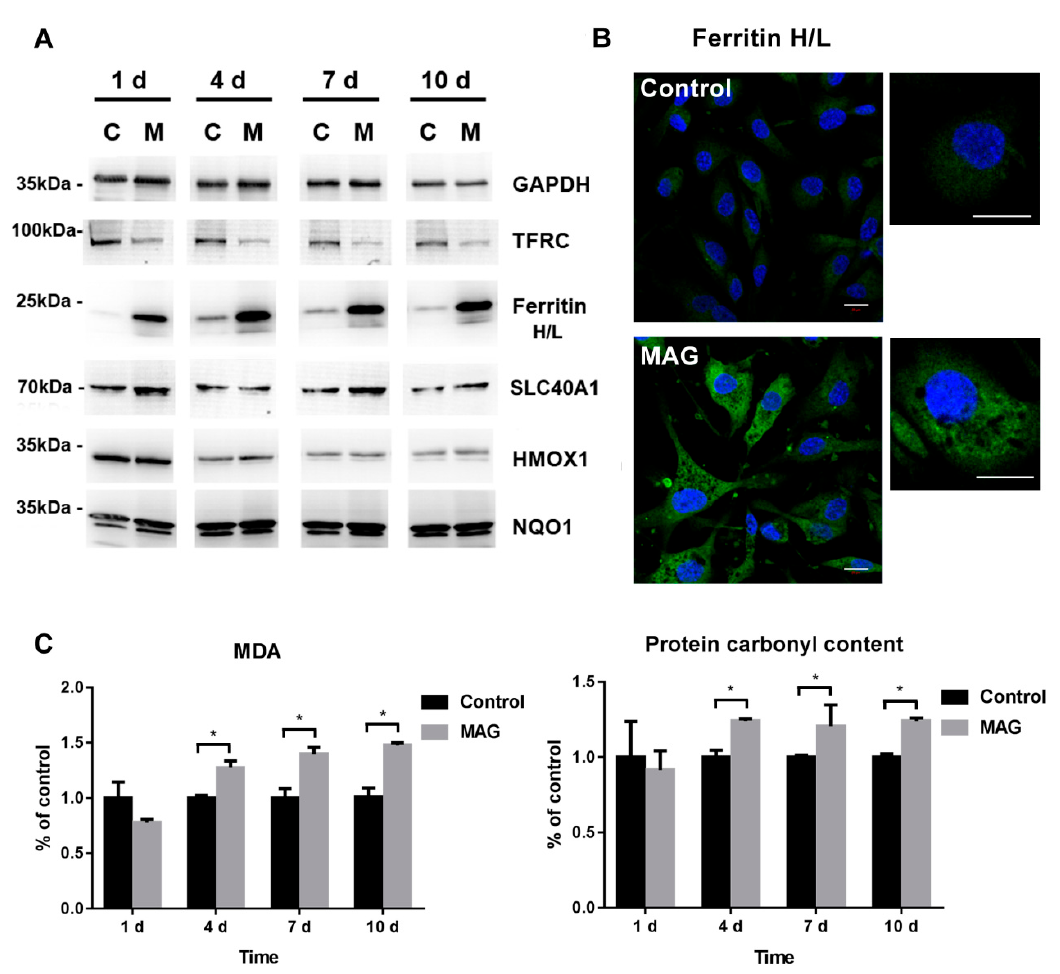
Figure 6. Evaluation of protein expressions and oxidative damage induced by MAGs in ECs. ( A ) The expression levels of proteins that are essential for limiting oxidative damage and iron metabolism in ECs. ECs were incubated with or without MAGs (10 µ g Fe/mL) and protein expressions were analyzed via Western blot on days 1, 4, 7, and 10. C, lysis of control cell without MAGs treatment; M, MAG-treated cell lysis. ( B ) Immunofluorescence observation of ferritin (green) expression in ECs treated with or without MAGs (10 µ g Fe/mL) on day 10. Cell nuclei (blue) were stained with 4 ′ ,6-diamidino-2-phenylindole (DAPI). Scale bar: 20 μ m. ( C ) Relative levels of malondialdehyde (MDA) and protein carbonyl groups in ECs incubated with or without MAGs (10 µ g Fe/mL). Lipid peroxidation marker, MDA, and carbonyl groups resulting from protein oxidation were measured by the MDA Assay Kit and Protein Carbonyl Colorimetric Assay Kit at different timepoints, as indicated. The treated samples were normalized to control at each timepoint, respectively, and the control was regarded as 1.0 (n > 3 for each timepoint, data are shown as the mean ± SD, * p -value < 0.05, control, ECs without MAGs treatment; MAG, ECs treated with MAGs).